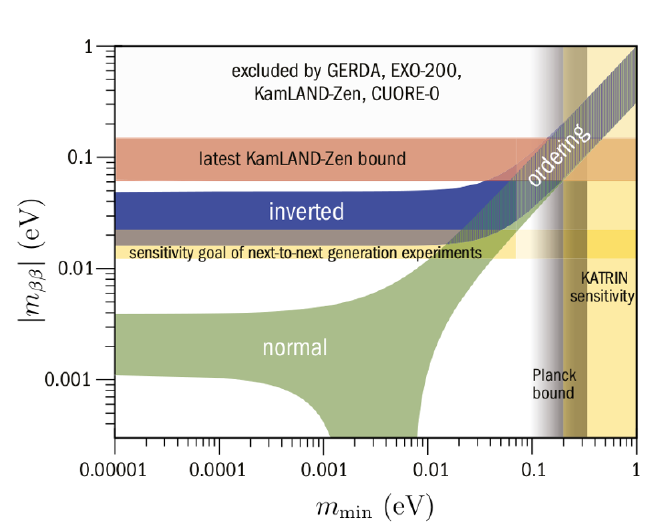
Figure 1 . Allowed parameter space for a 0 (cid:23)(cid:12)(cid:12) signal, as a function of the smallest neutrino mass, for both possible hierarchies. Current experimental bounds are also shown. Taken from